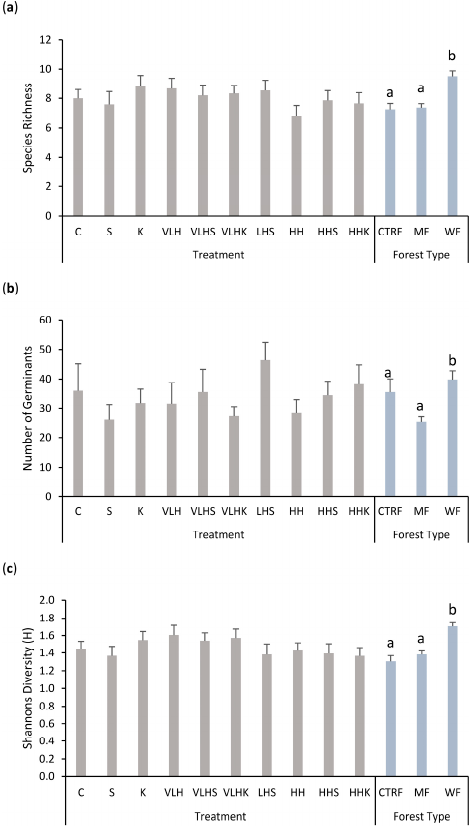
Figure 1. ( a ) Species richness, ( b ) abundance, and ( c ) Shannon’s Diversity (H) of soil seed bank germinants by treatment and forest type. Values are site means and bars one standard error. There were no signi fi cant di ff erences among treatments. For forest type, le tt ers indicate signi fi cant ( p ≤ 0.05) pairwise di ff erences. Statistical analysis was based on log 10 (x + 1) transformed values of abundance, but graphical display generated from raw data. Model results provided in Table S3. There were no signi fi cant interaction e ff ects.